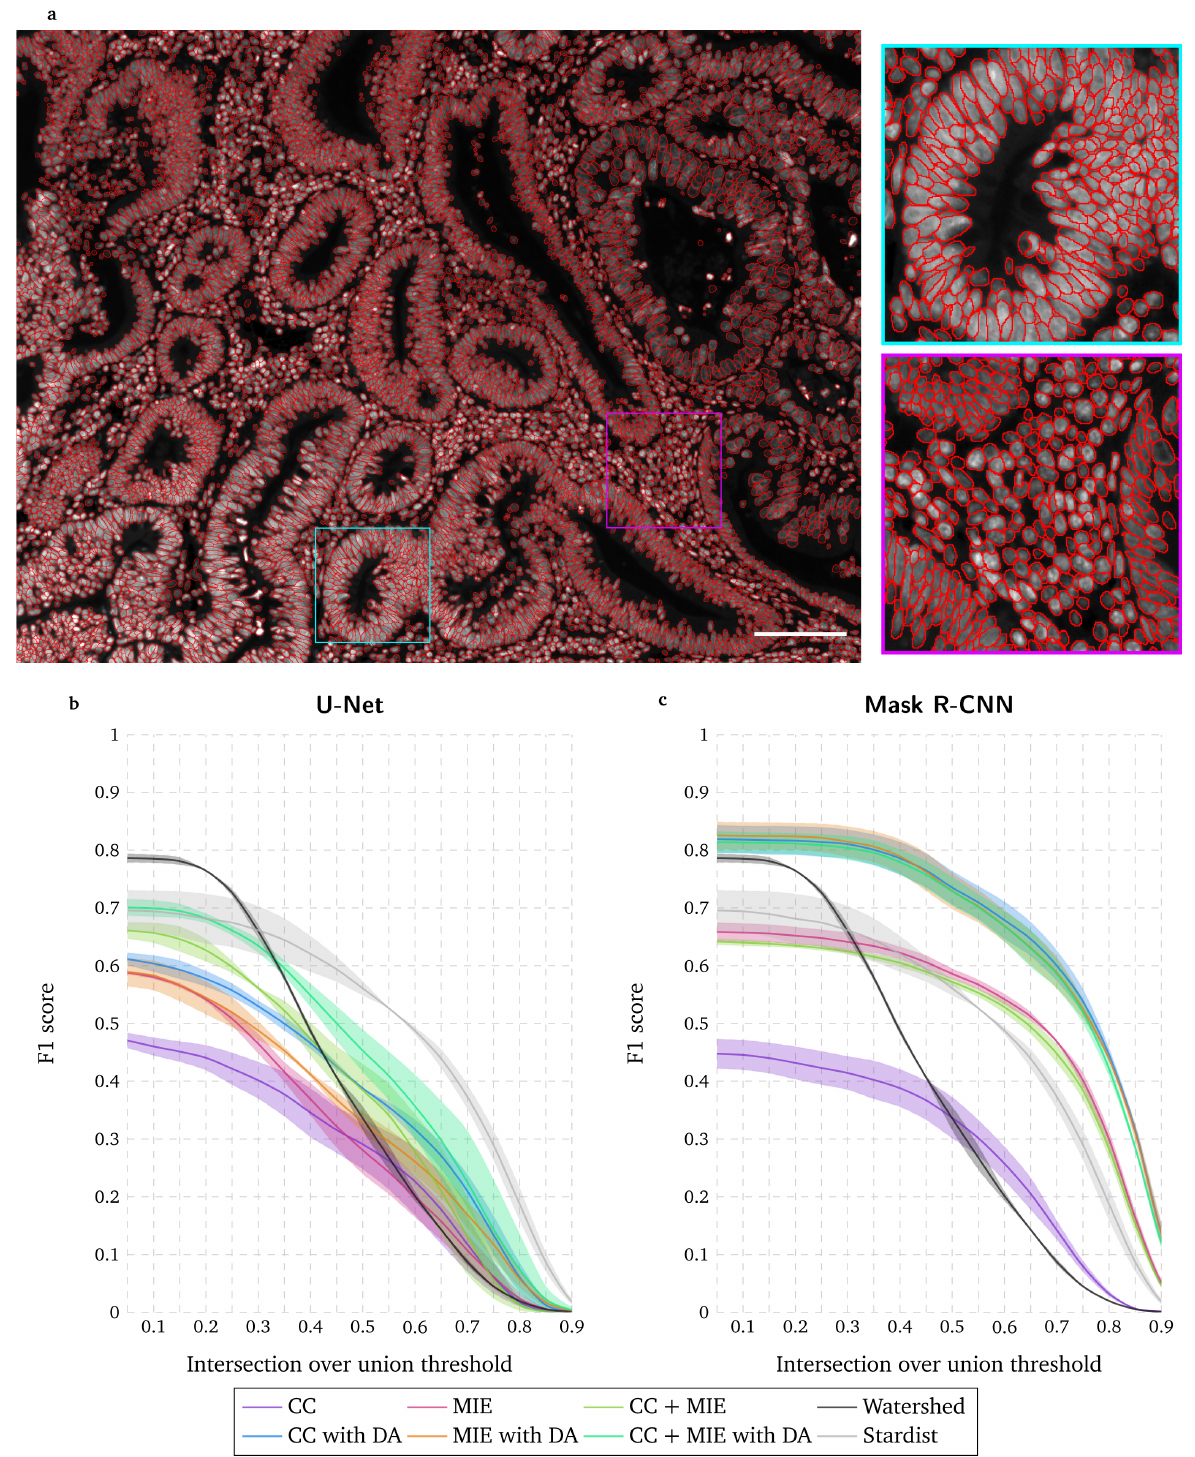
Figure 1. Manual annotation and evaluation of deep learning-based segmentation with existing training datasets. a Widefield acquisition of a human polyp biopsy stained with DAPI. Manually annotated nuclei are overlaid as red circles. Zoomed-in regions are displayed on the right side with corresponding squared colors. Scale bar = 100 µ m. b – c F1 score for range of IoU thresholds obtained with the watershed method, with Stardist, with U-Net b and Mask R-CNN c approaches trained with a high-throughput chemical screen on U2OS cells dataset (CC) or/and a widefield mouse intestinal epithelium dataset (MIE), with and without data augmentation (DA). Lines correspond to average F1 score over the two tested images while the shaded areas represent the standard deviation.